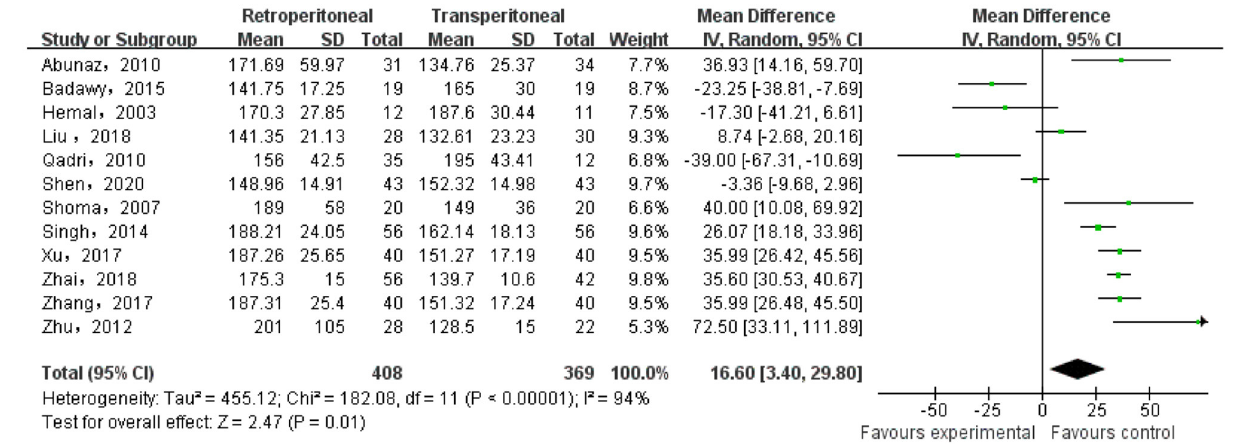
FIGURE 2 | Meta-analysis of the operative time.